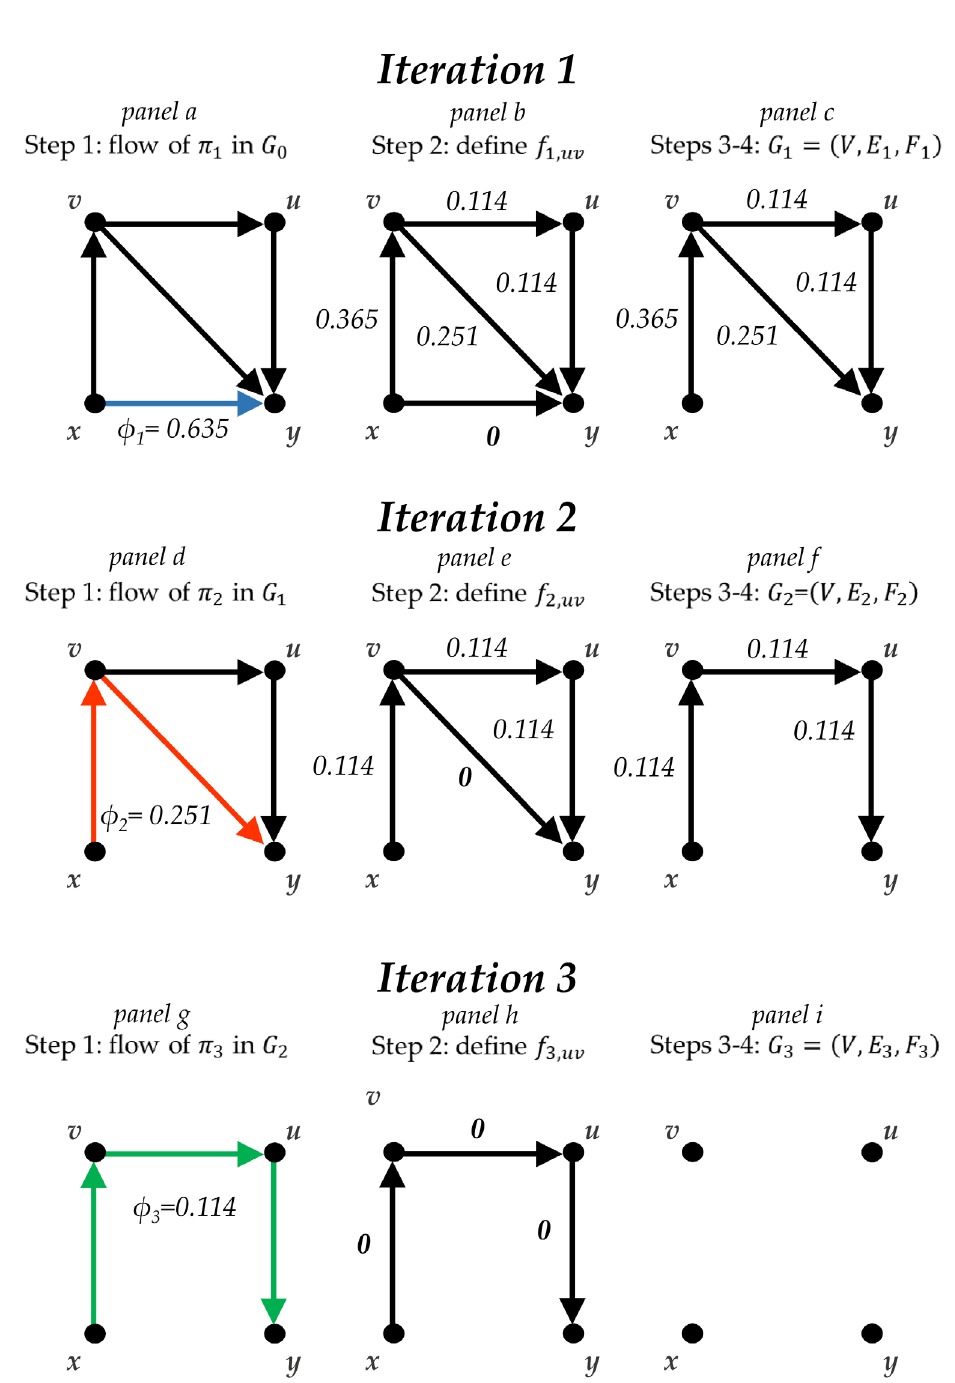
Figure 2. Illustration of the steps of the algorithm for approximating proportion contributions per comparison in the network of topical antibiotics without steroids for chronically discharging ears focusing on the comparison ‘ x versus y ’. Treatment labels: x , no treatment; y , quinolone antibiotic; u , non-quinolone antibiotic; v , antiseptic.